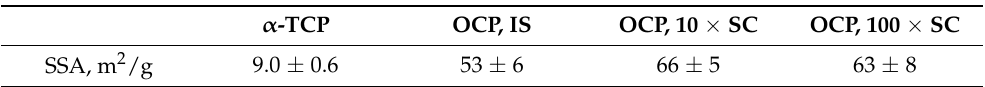
Table 1. Specific surface area of the starting precursor and the final OCP phases at all levels of scale ‐ up.